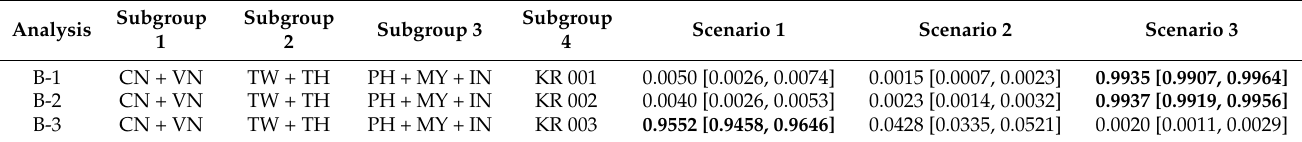
Table 4. The most likely demographic scenario by the DIYABC analysis ‘B’ to trace the origin of the B. dorsalis quarantine- detected groups on the Korean Peninsula (see Figures S2 and S8). Subgroup 4 to KR 001, 002 or 003, and each analysis was performed to trace the origin of each Korean group’s introduction route. Subgroup 4 set to KR 001 in Analysis B-1, KR 002 in B-2 and KR 003 in B-3. Scenario 1: Subgroup 4 introduced from Subgroup 1 (CN + VN). Scenario 2: Subgroup 4 introduced from Subgroup 3 (PH + MY + IN). Scenario 3: Subgroup 4 introduced from Subgroup 2 (TW + TH). In Analysis B-1, Scenario 3 was most suitable for KR 001 (Supplementary Materials Figure S8B-1). Values in bold indicate the best scenario in each